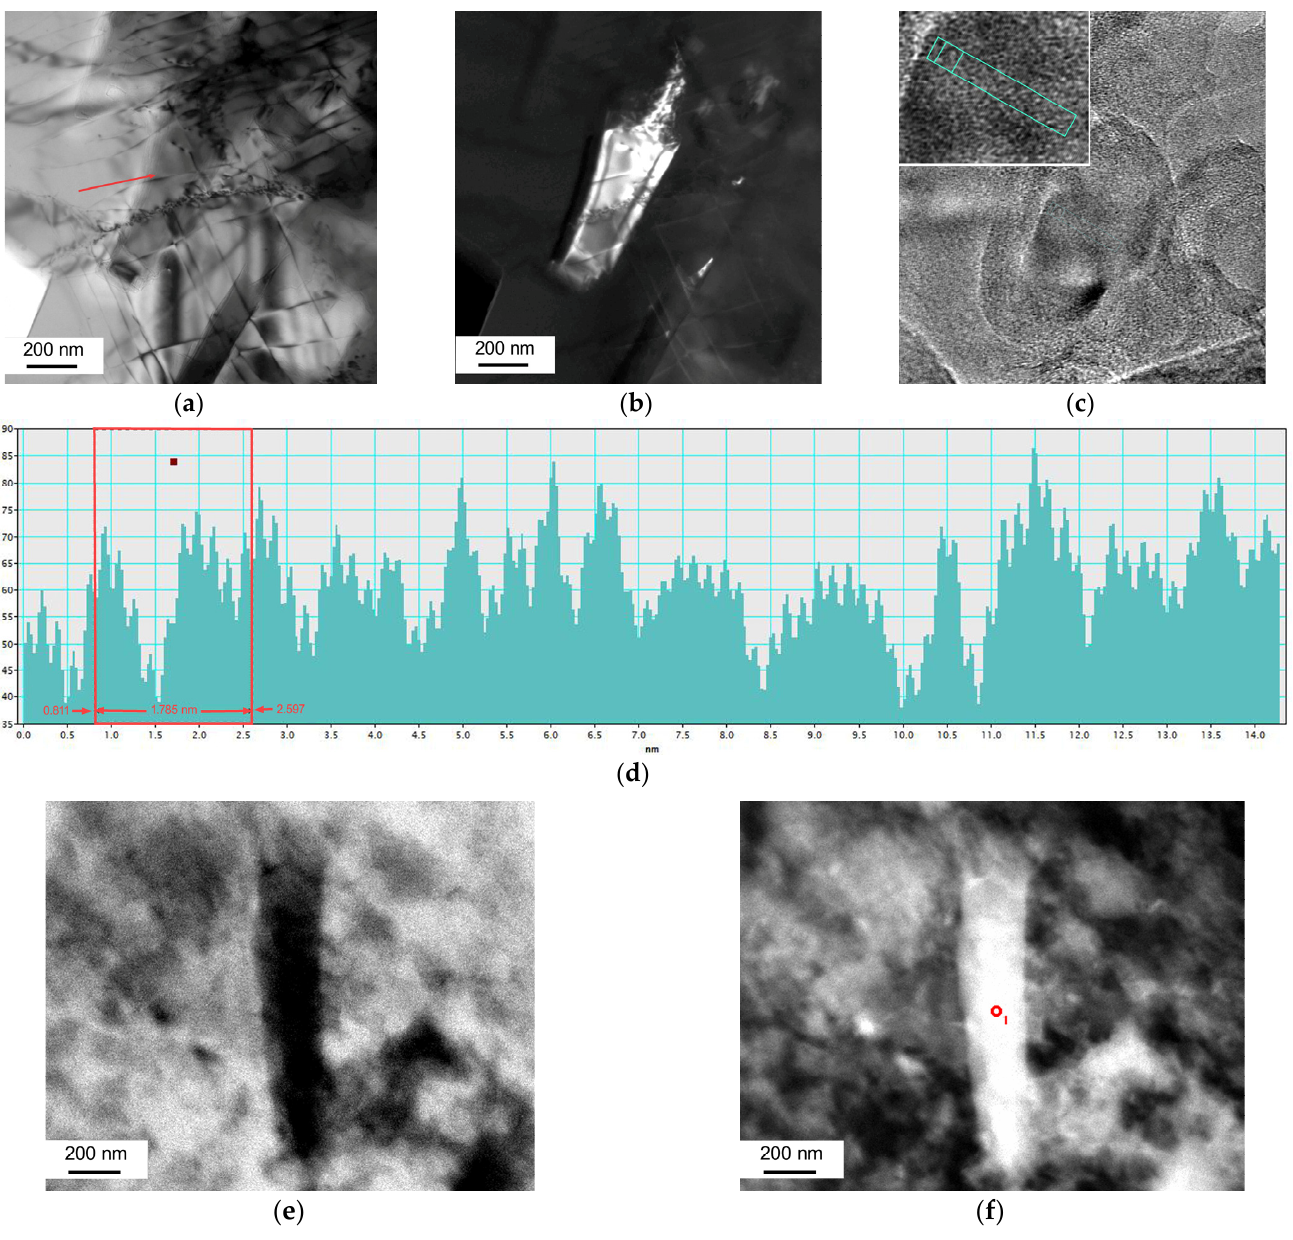
Figure 6. Fragments of graphene nanoplatelets in ( a – d ) AlGr composite and ( e , f ) AlMgGr composite after Hopkinson bar compression tests: ( a ) bright-field image and ( b )dark-field image in reflections of (100) Gr . ( c , d ) Direct imaging of graphene crystal structure: ( c ) inverse Fourier transform of the image, d = 0.31785 nm; ( d ) intensity histogram (10d = 1.785 nm). ( e ) Bright-field STEM image and ( f ) dark-field image.